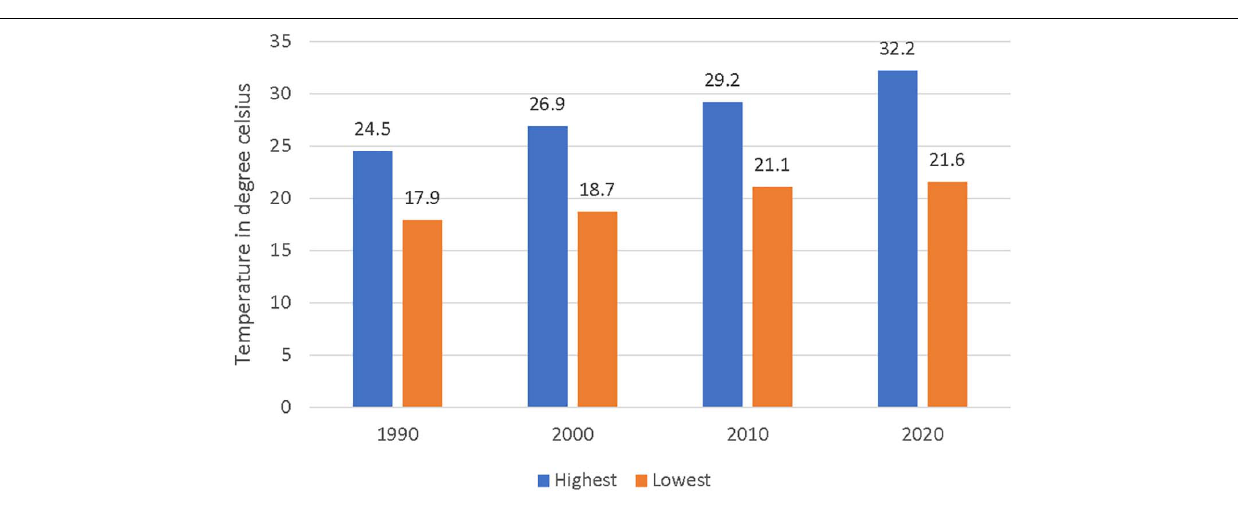
FIGURE 6 | Change in temperature ( ◦ C) with time in DDWS from 1990 to